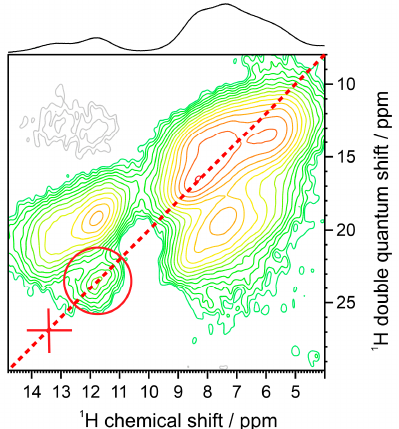
Figure 6. Double quantum-single quantum 1 H- 1 H correlation spectrum of 2d recorded at 25 kHz MAS, and 2 rotor periods double-quantum recoupling using the BABA-xy16 pulse sequence.